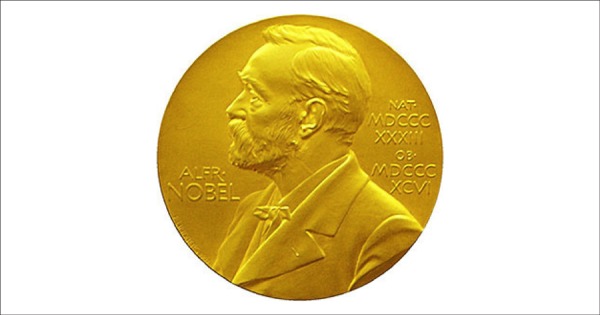
Nobel Prize Logo.